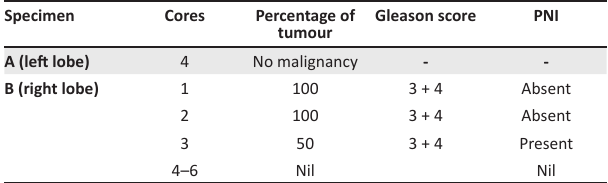
TABLE 1: Summary of transrectal ultrasound prostate biopsy. Specimen